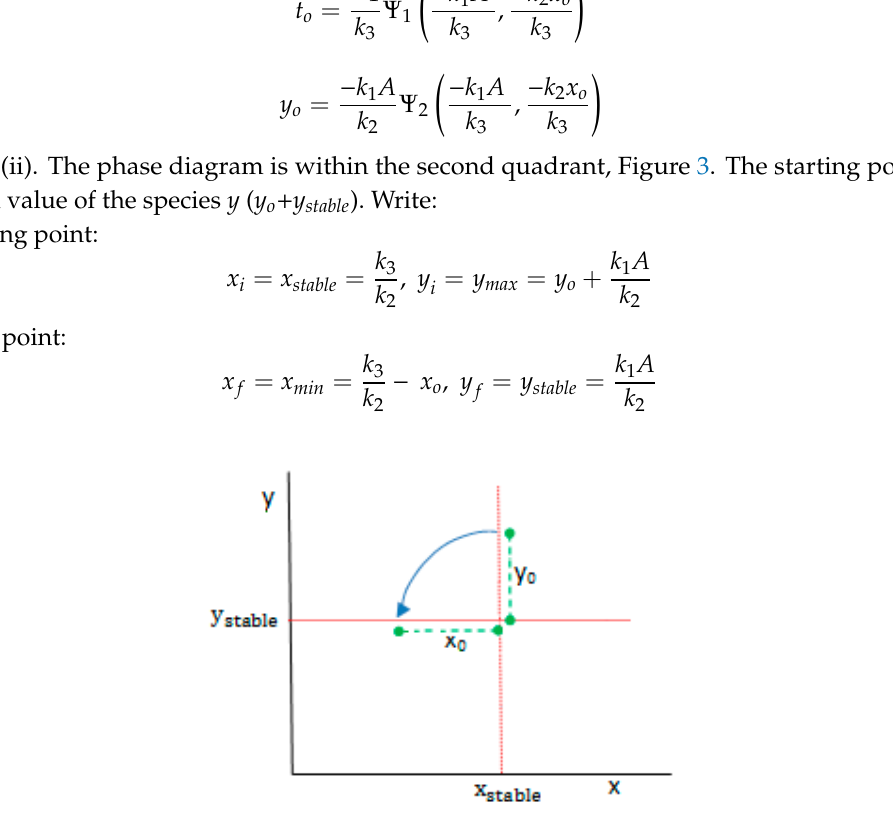
Figure 3. Starting and ending position of the path of the second quadrant.